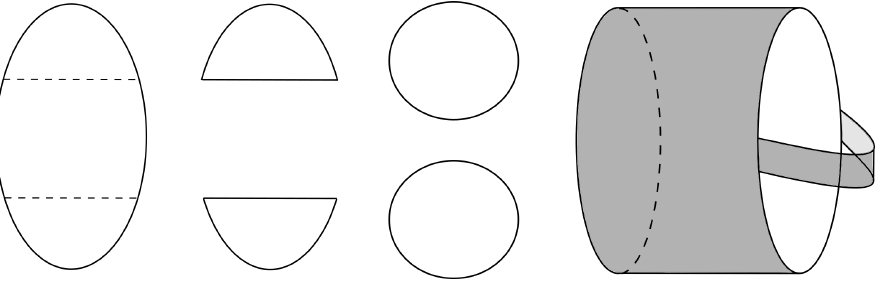
Figure 4.1: Surgery on an embedded S 0 × D 1 in the circle, and its trace. Note how the trace deformation retracts onto a circle with an interval